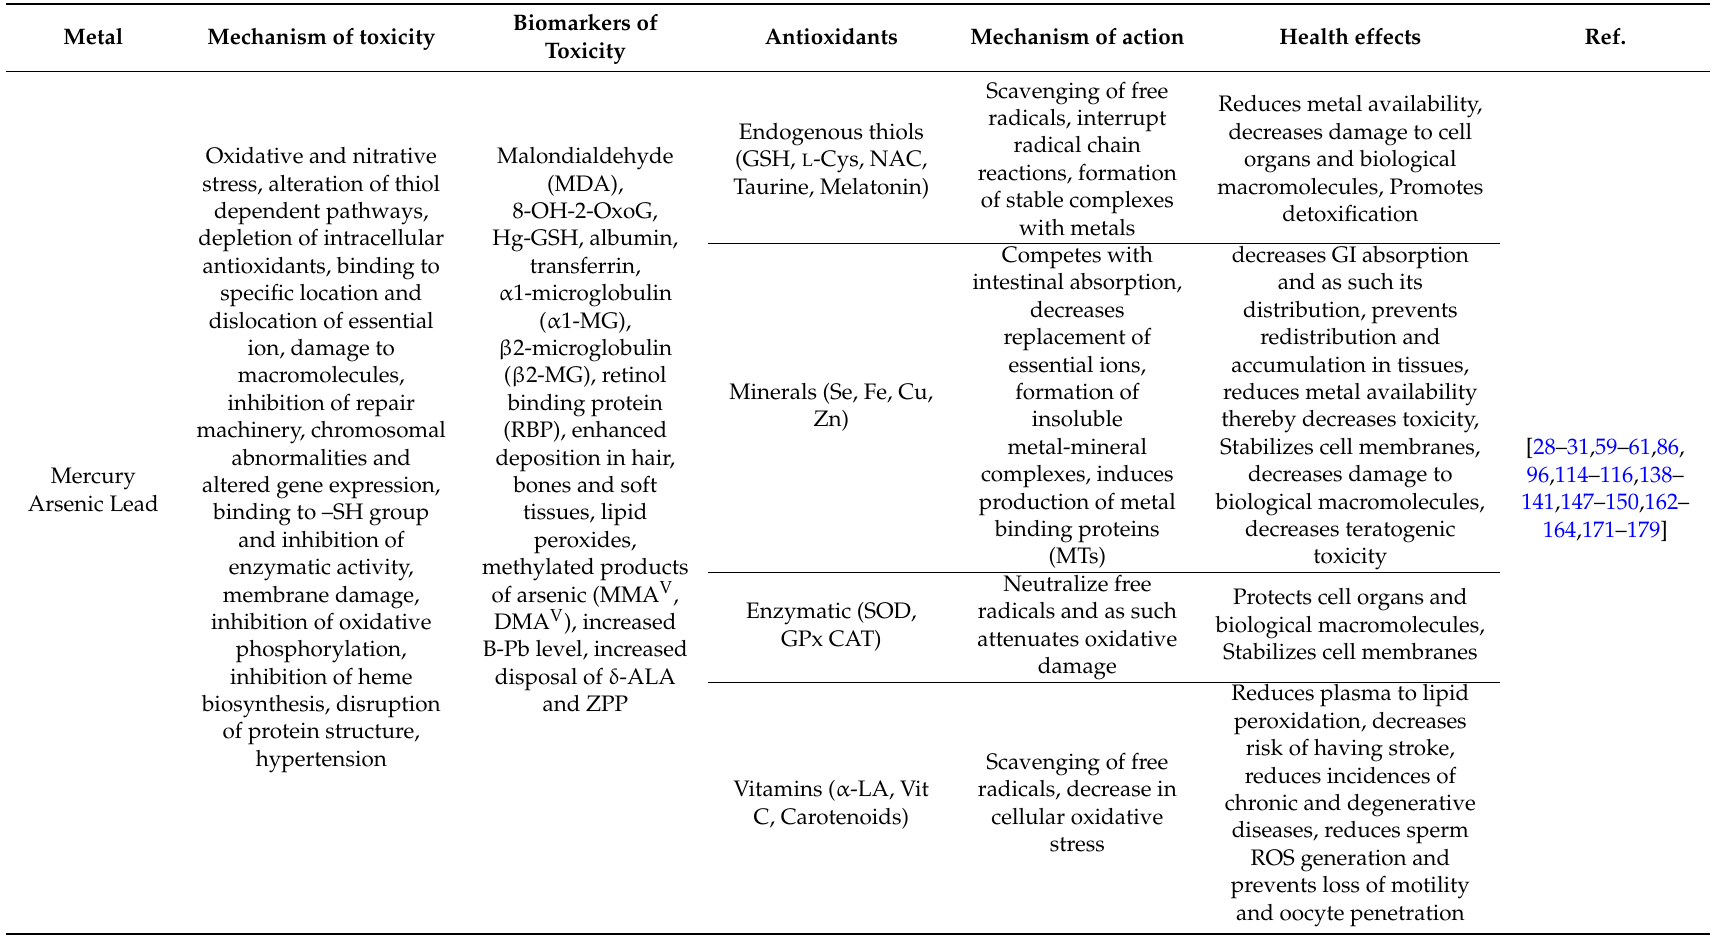
Table 2. Mechanistic insight into metal toxicity and mode of action of antioxidants and their health benefits in overcoming the deleterious effect of